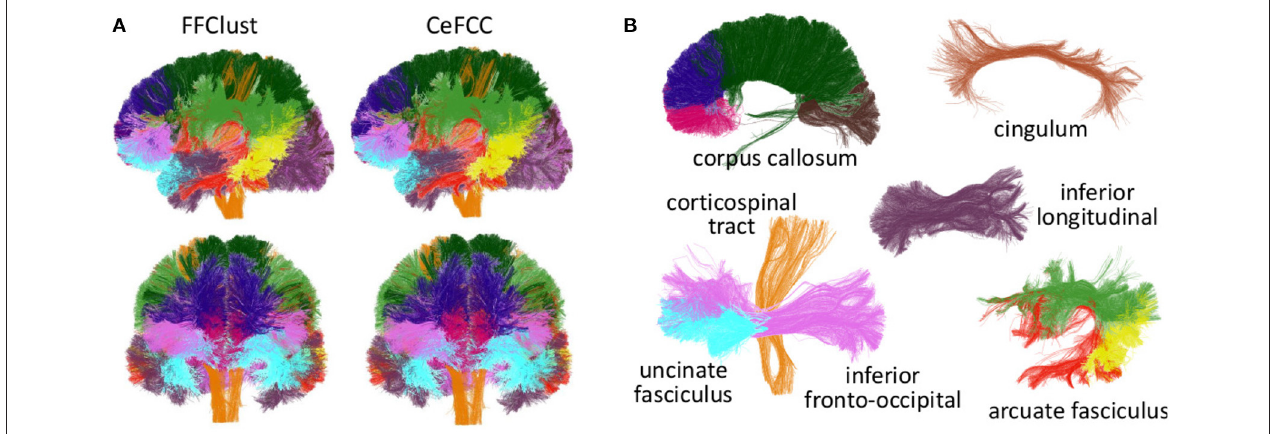
FIGURE 10 | Segmented bundles for FFClust and CeFFC algorithms (one subject). (A) All the segmented bundles. First row: left sagittal view, second row: coronal view. (B) The segmented bundles on separated displays for CeFFC algorithm (left sagittal view). Corpus Callosum: rostrum (magenta), genu (blue), body (dark green) and splenium (brown). Cingulum (light brown), inferior longitudinal fasciculus (dark purple), corticospinal tract (orange), uncinate fasciculus (light blue), inferior fronto-occipital fasciculus (pink). Arcuate fasciculus: direct segment (red), anterior segment (green), posterior segment (yellow).